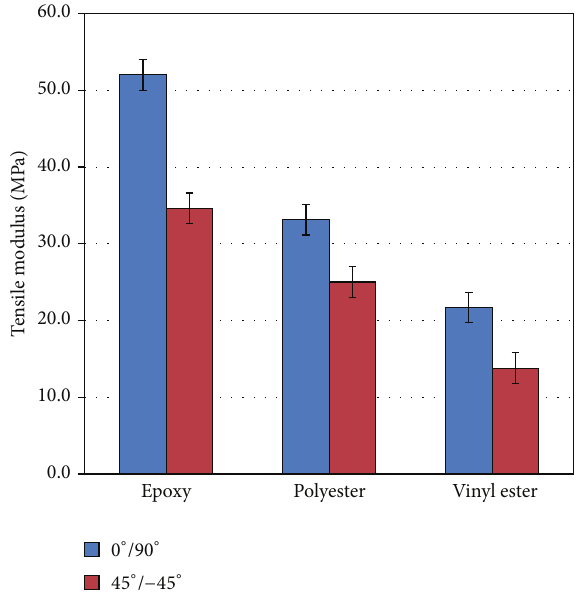
Figure 4: Tensile modulus of three composites at 0 ∘ /90 ∘ and 45 ∘ / − 45 ∘